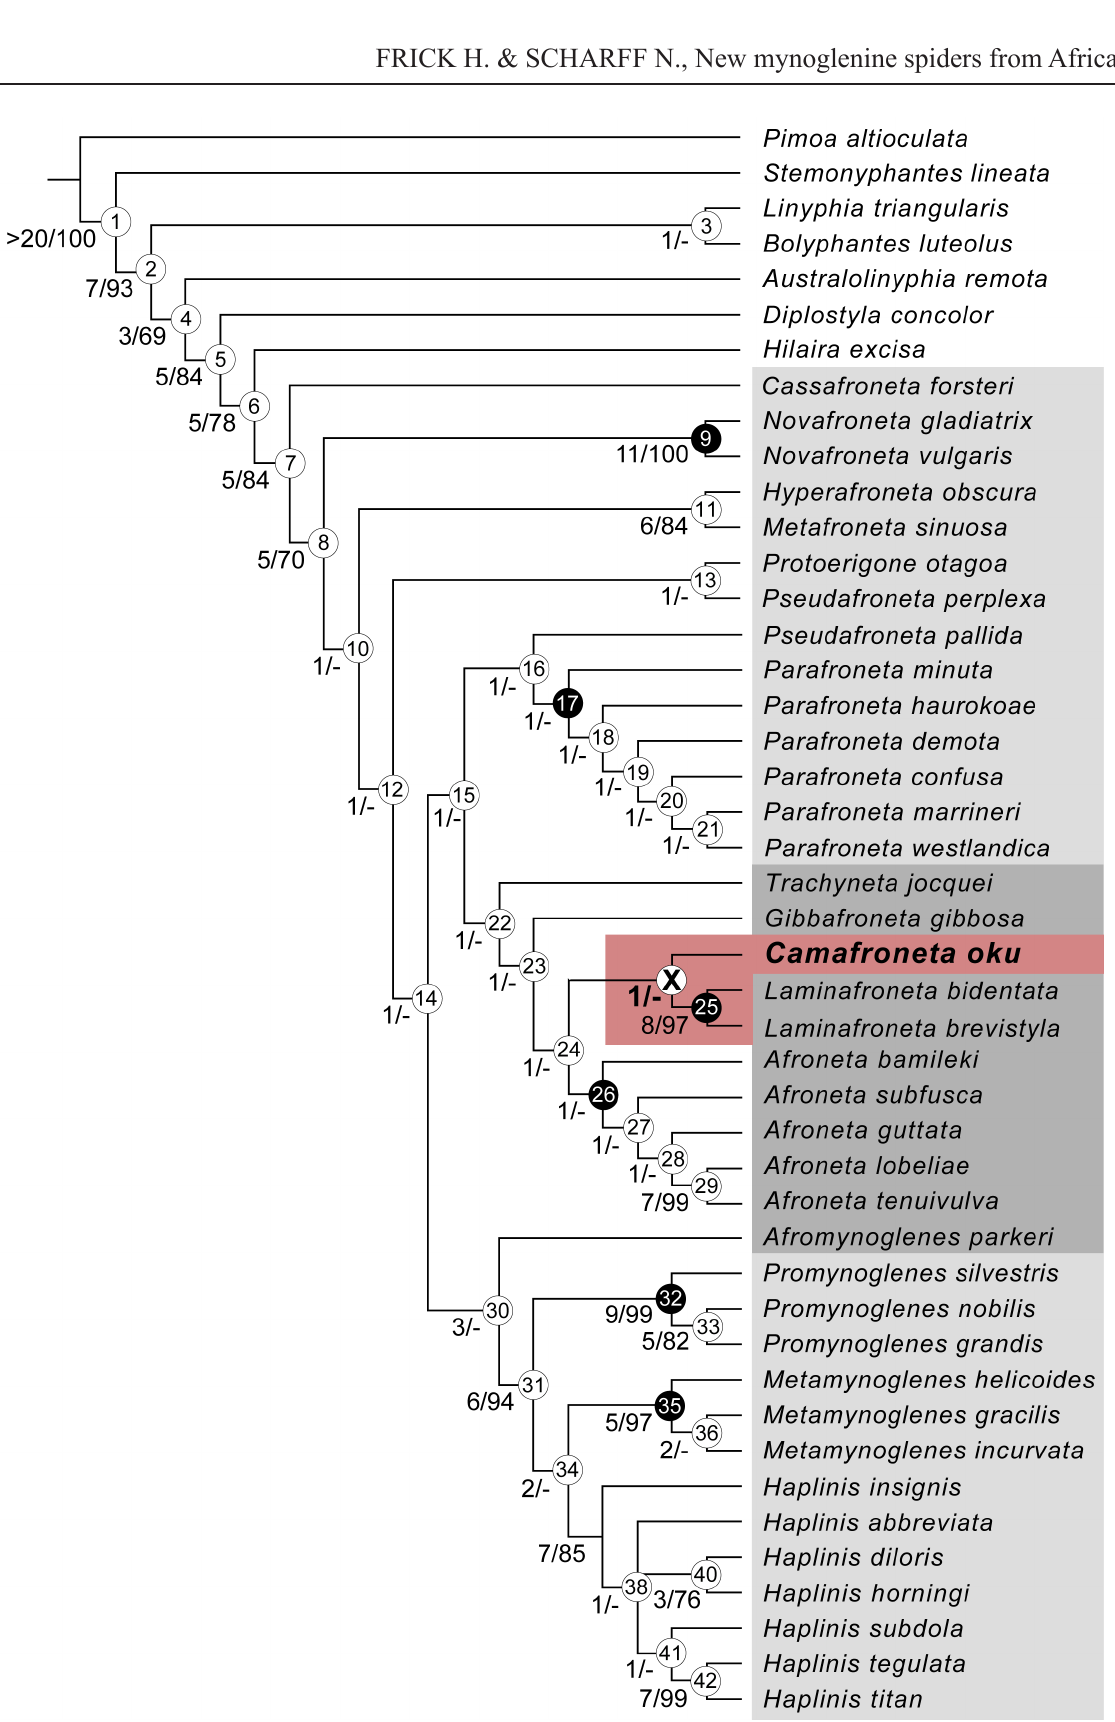
Fig. 14. Phylogeny of Frick & Scharff (2014) with Camafroneta oku sp. nov. added to